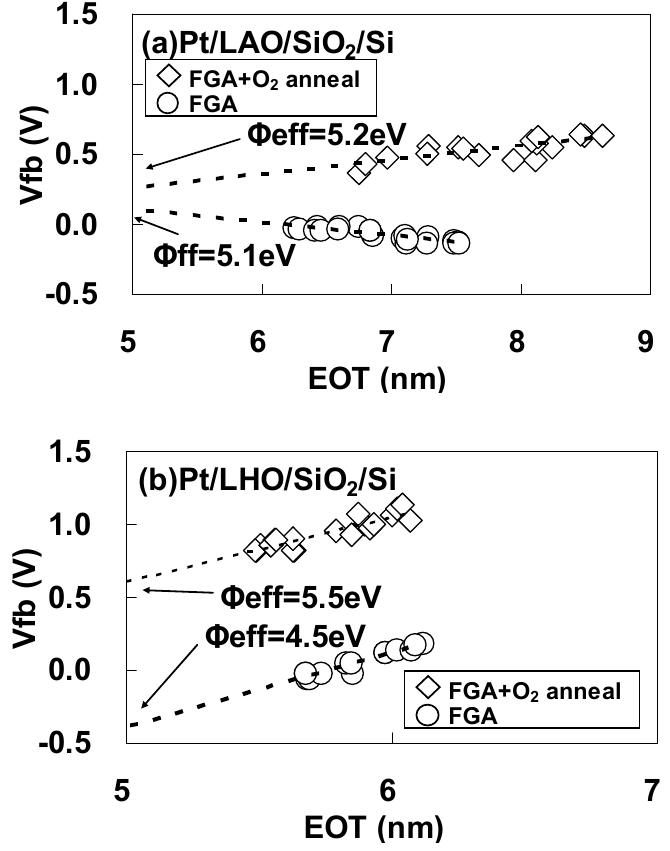
annealing Figure 22. Dependence of Vfb on EOT after FGA only and after additional O 2 /Si and ( b ) Pt/LHO/SiO /Si MOS capacitors. φ eff was estimated from for ( a ) Pt/LAO/SiO 2 2 the point of intersection of the EOT = 5 nm vertical line with the extrapolated experimental data by assuming that a fixed charge was responsible for the local slope of layer and LAO or LHO. This assumption is the plot at the interface between the 5-nm SiO 2 thickness was based on the experimental result that the dependence of Vfb on the SiO 2 /Si capacitors (data not small for Pt/SiO 2